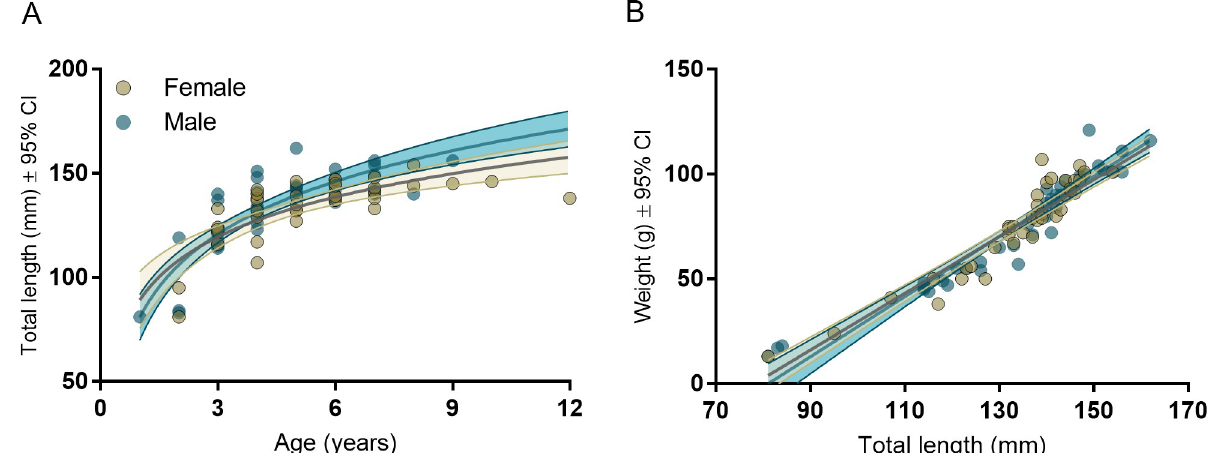
Fig 2. (A) Length vs Age and (B) Weigth vs Length relationships for 76 individual Heniochus varius (25 pairs as well as 26 single individuals where the other member of the pair was not caught). Males are dark blue and females are gold.